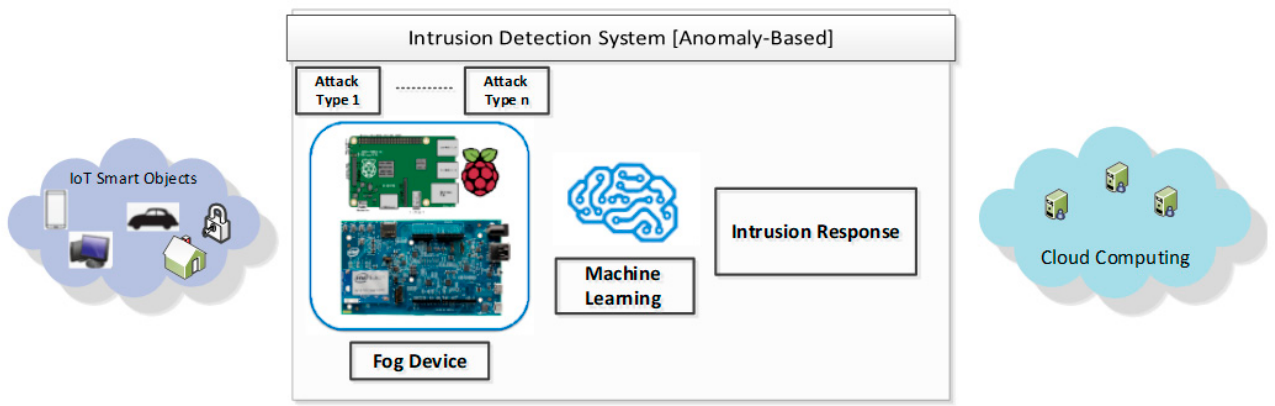
Figure 1. The structure of IDS—lightweight for IoT network using Fog Computing. The Main Motivations of This